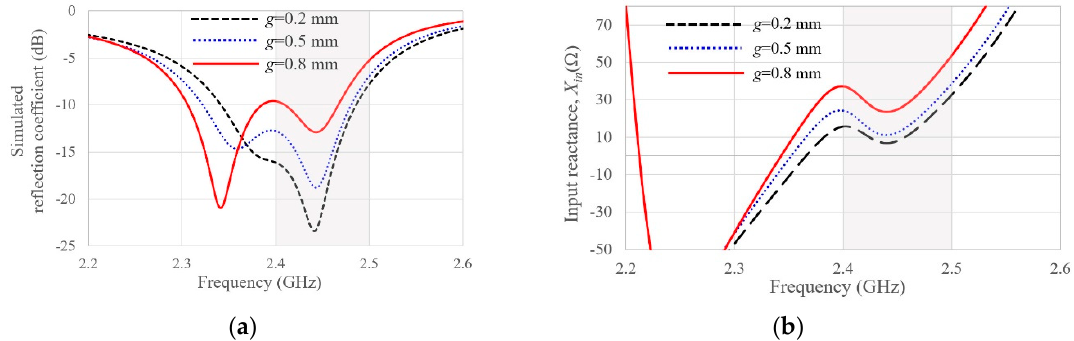
Figure 4. Input impedance matching in P-fed I-shape MSA through coupling gap g adjustment (refer to Table 2 for dimensions of the antenna). ( a ) Simulated reflection coefficient; ( b ) input reactance, X in .